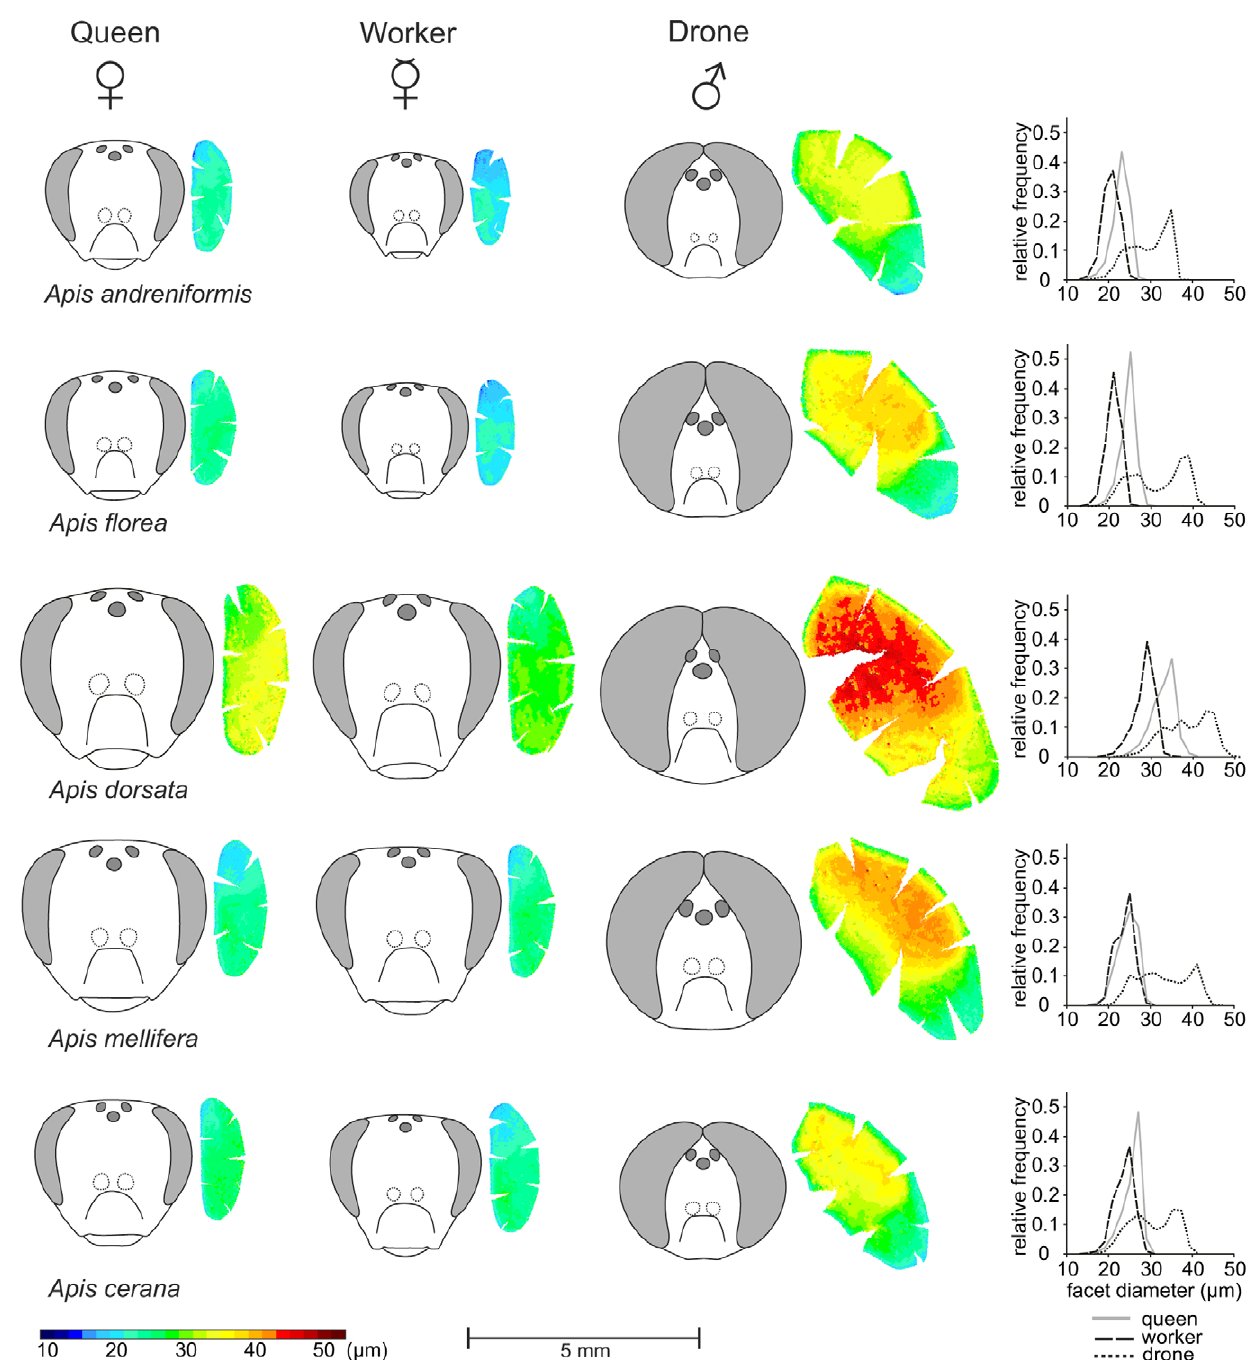
Figure 2. Facet size distribution in compound eyes. Eye maps illustrate eye size differences and facet size distribution between castes and sexes of the Western and four Asian honeybee species. Each circle represents one facet lens. Color indicates facet size (scale at the bottom). The largest facets in queens and workers are usually found in the fronto-ventral region of the eye. In drones, facet diameters are dorso-ventrally separated and the largest facets are found in the dorsal two-thirds of the eye. The eye maps are accompanied by line drawings of all individuals, which allow comparison of eye placement, eye size and ocellar size between species, sexes and castes (all to scale, scale bar 5 mm). Relative facet diameter frequencies are illustrated by histograms (right panel, bin width 2 m m) of one randomly selected queen (gray line), worker (dashed line) and drone (dotted line) from each species. doi:10.1371/journal.pone.0057702.g002 facet diameters, but not ommatidia number, suggesting that however, may limit their foraging abilities during the twilight workers trade-off light sensitivity to retain spatial resolution, which hours, compared with the species that possess larger facet diameters [13]. Somanathan et al. [24] recently investigated the is important in foraging tasks. The smaller facet diameters,